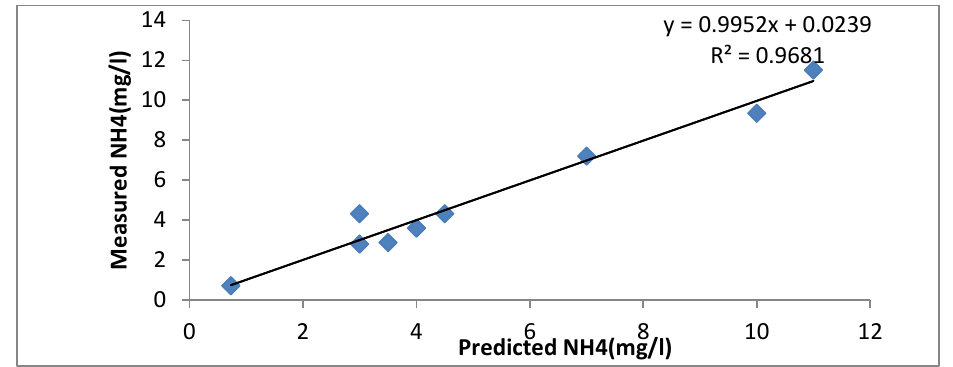
Fig. 6. Comparison between observed and predicted NH